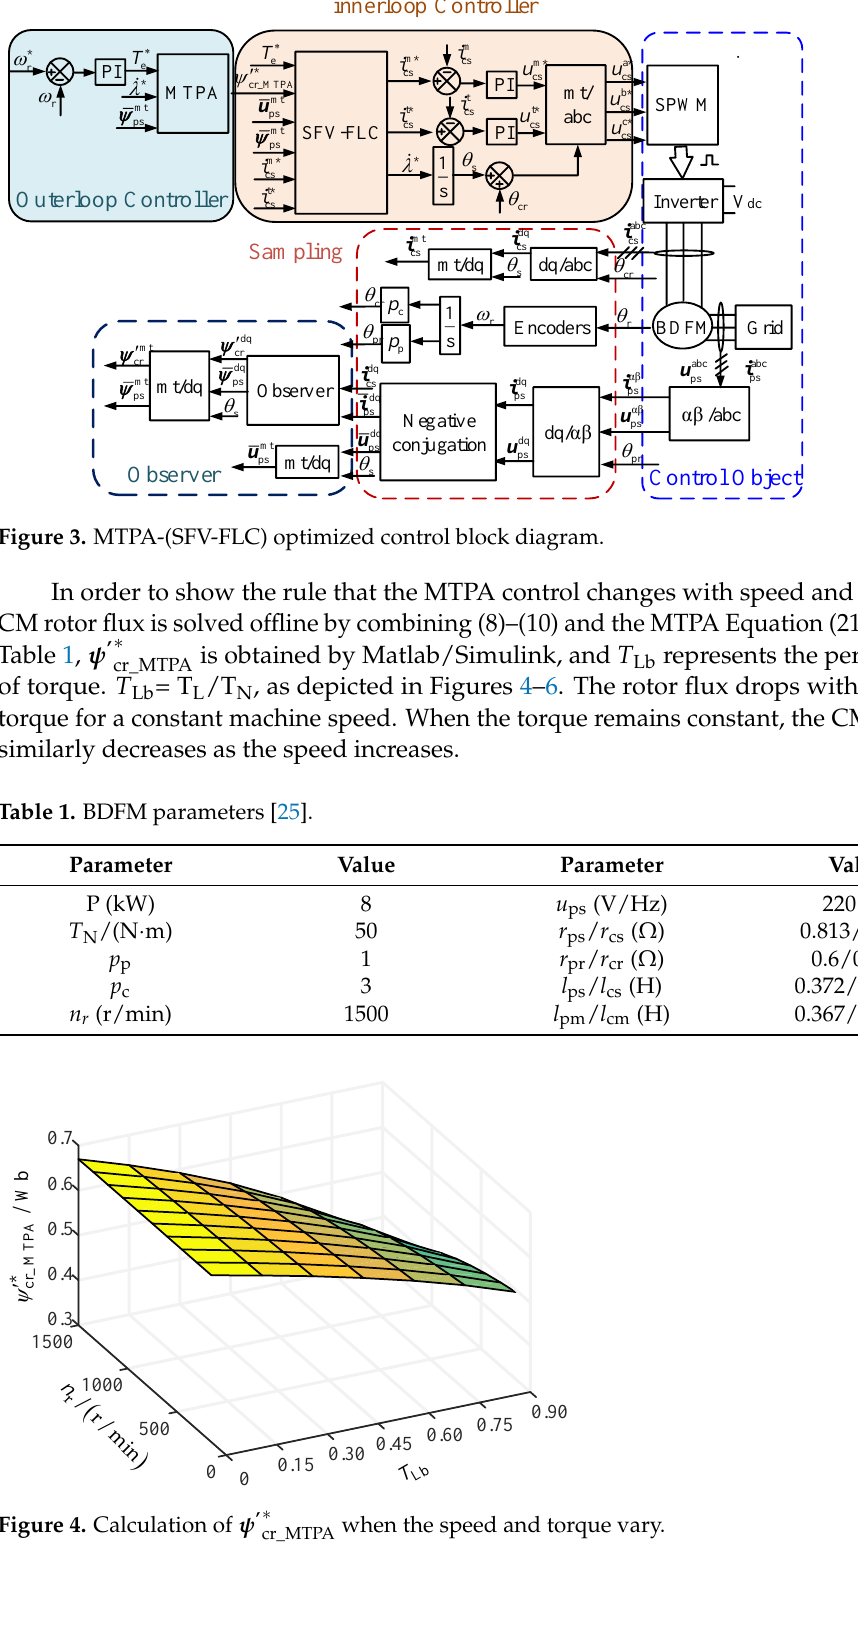
s k k + Figure 2. MTPA online computing block diagram.